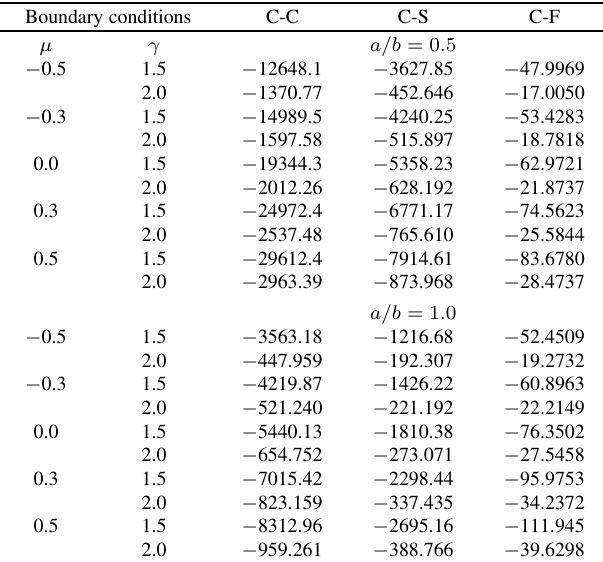
Table 2 Values of lowest critical buckling loads N ∗ cr for C-C, C-S, and C-F